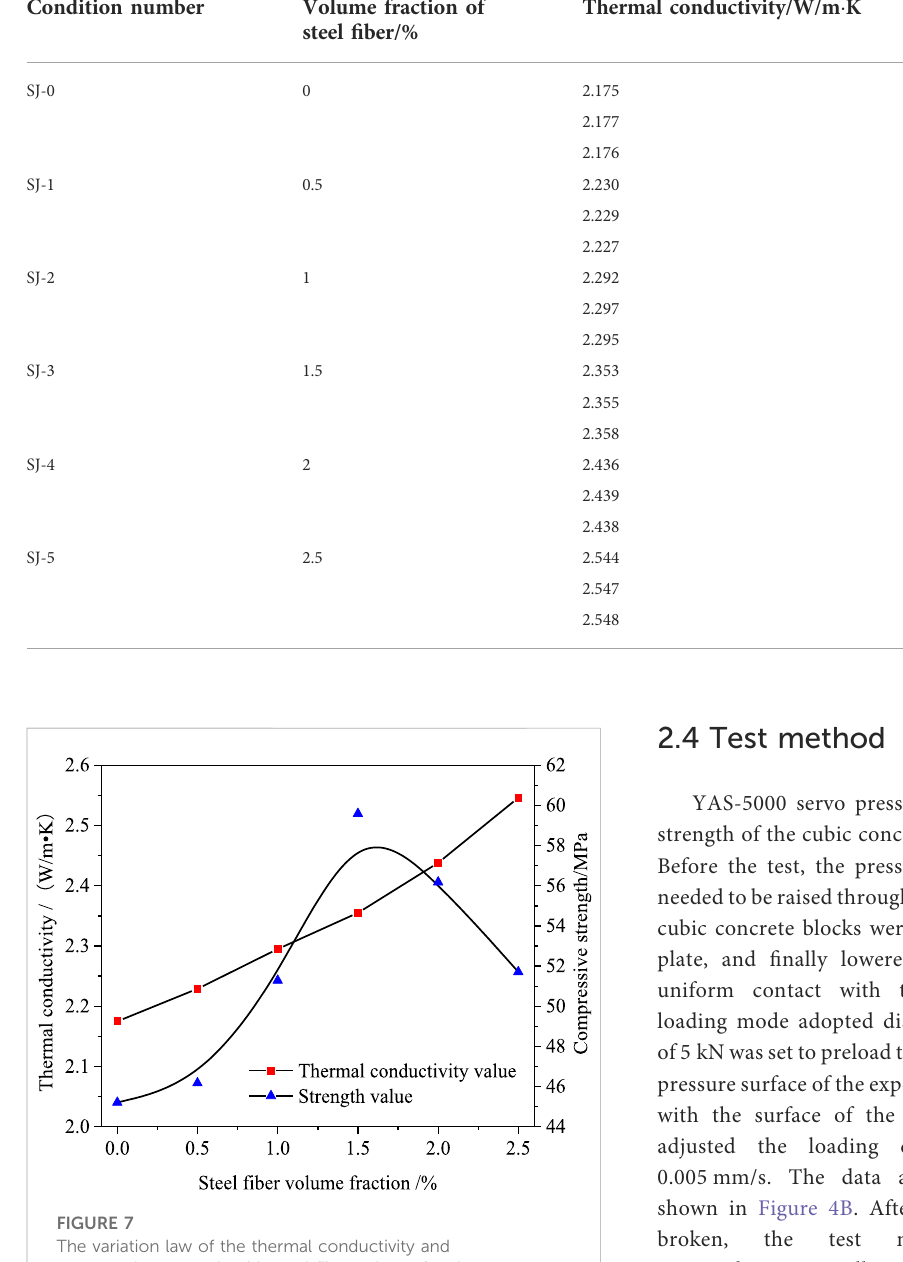
FIGURE 7 The variation law of the thermal conductivity and compressive strength with steel fi ber volume